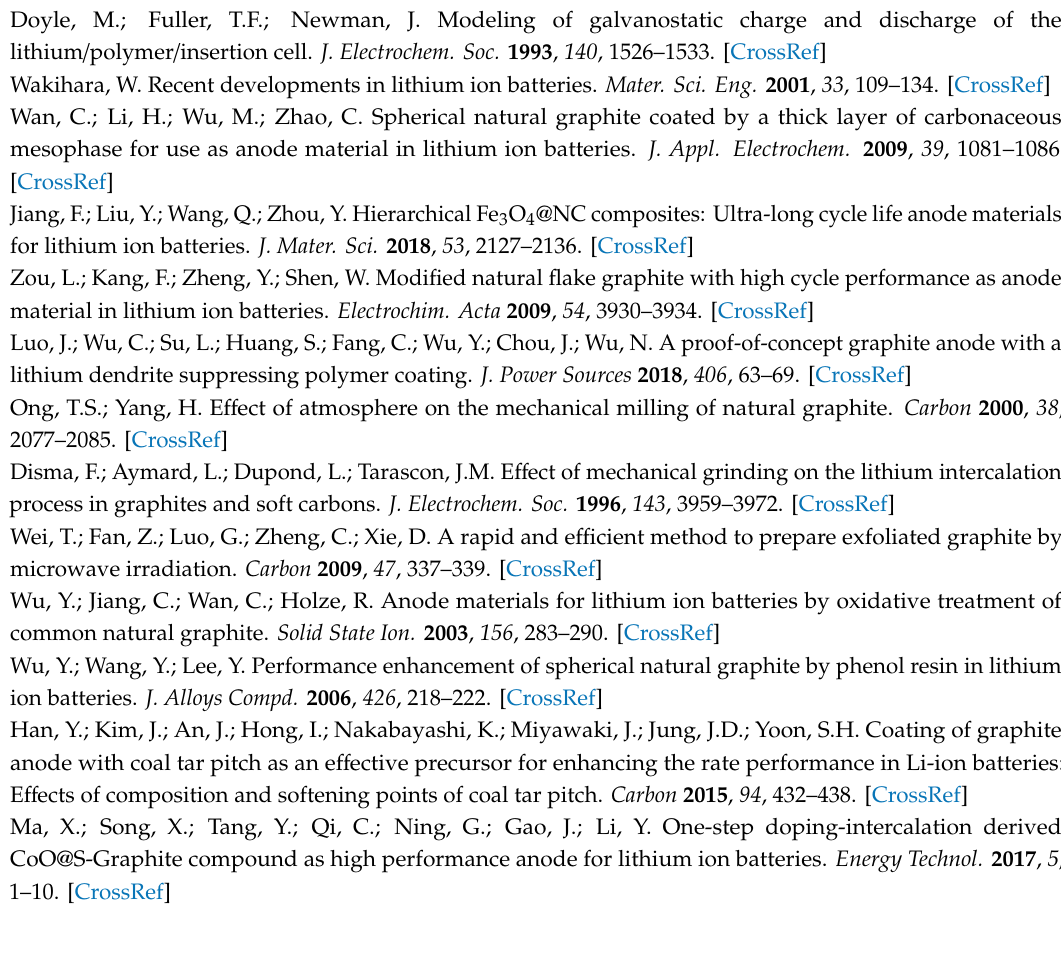
of three samples. Figure S4: Galvanostatic lithiation / delithiation curves of (a) SG and (b) SGO at 0.1 A g − 1 . Figure S5: (a) Cycling performance at 0.5 A g − 1 , (b) rate performance, and (c) long term cycling performance at 2 A g − 1 of Fe 3 O 4 hollow nanospheres. Figure S6: SEM images of (a) SGO / Fe 3 O 4 -1, (b) SGO / Fe 3 O 4 -2, (c) SGO / Fe 3 O 4 -3, (d) SGO / Fe 3 O 4 -5 composites. Figure S7: TG curves of di ff erent composites. Table S1: Electrochemical impedance fitted parameters for Figure